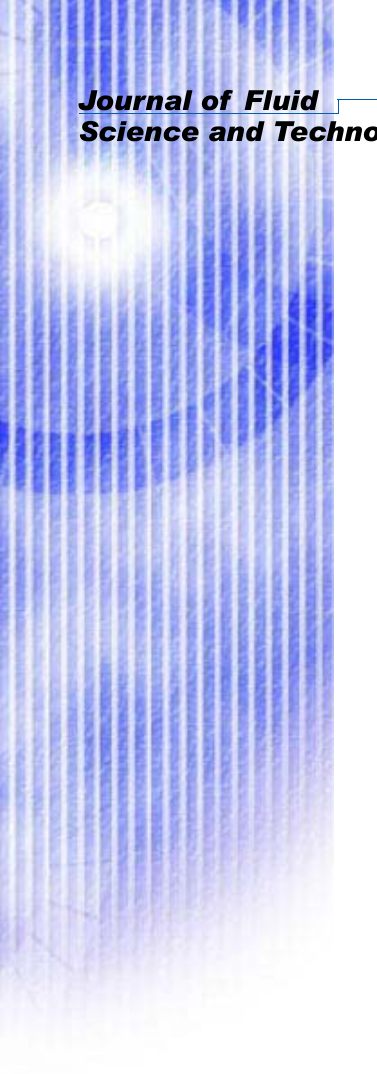
( ) ZI is expressed f